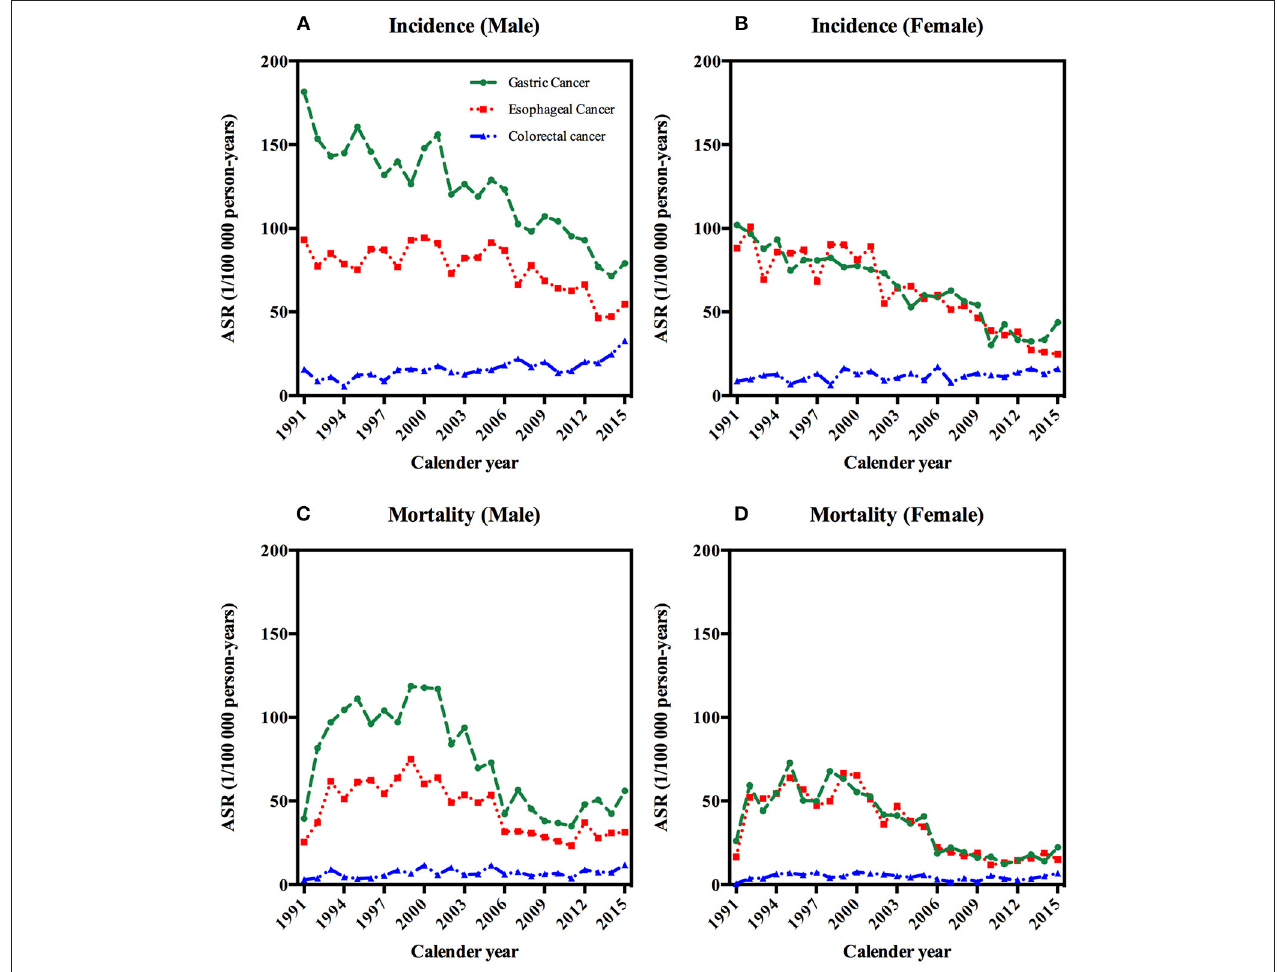
FIGURE 1 | Age-standardized incidence and mortality rates of gastrointestinal cancers by sex in Yangzhong, 1991–2015. (A) Age-standardized incidence rates of gastrointestinal cancers in males. (B) Age-standardized incidence rates of gastrointestinal cancers in females. (C) Age-standardized mortaity rates of gastrointestinal cancers in males. (D) Age-standardized mortaity rates of gastrointestinal cancers in